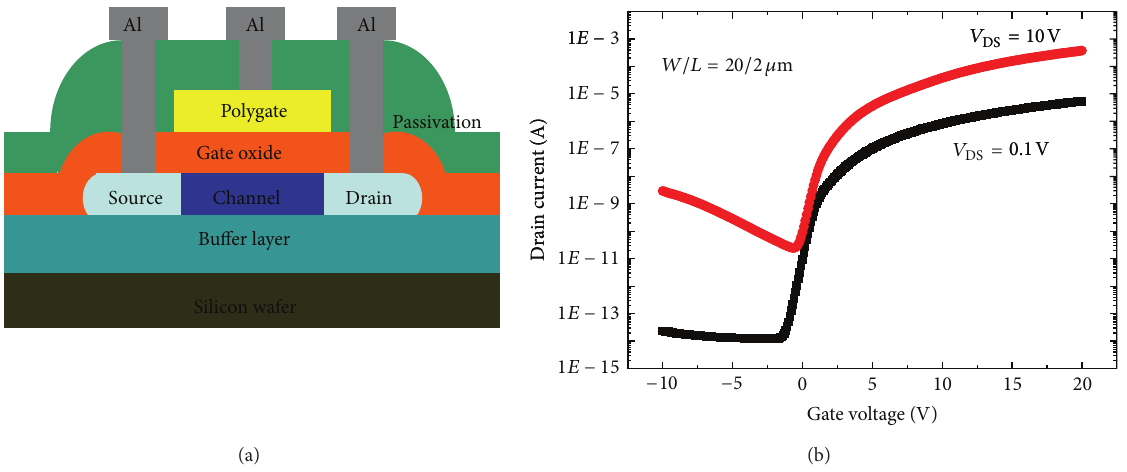
Figure 1: (a) Cross-section of the poly-Si TFT. (b) The device transfer curve.